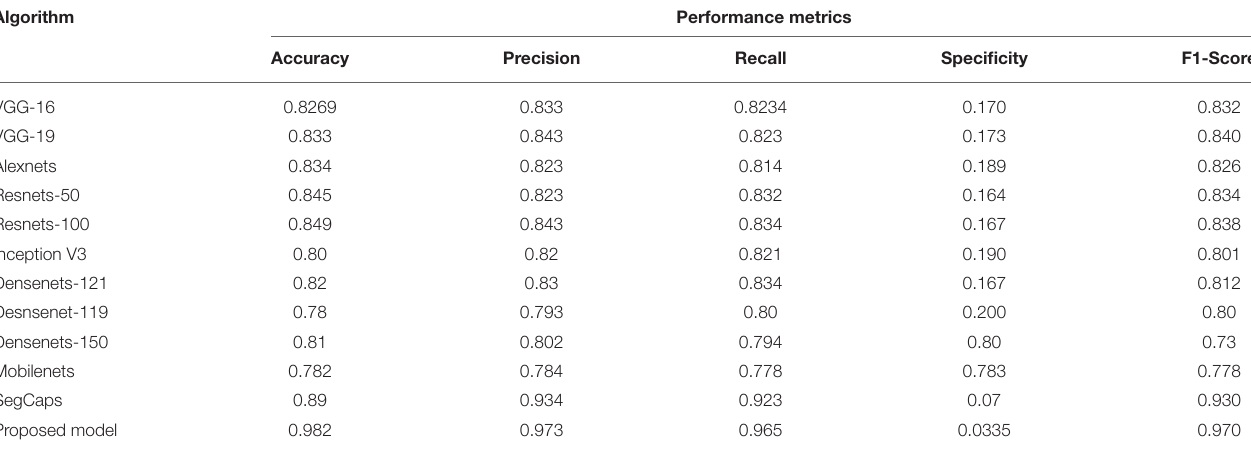
TABLE 2 | Comparative analysis of the different algorithms in detecting the COVID-19 using dataset 1.